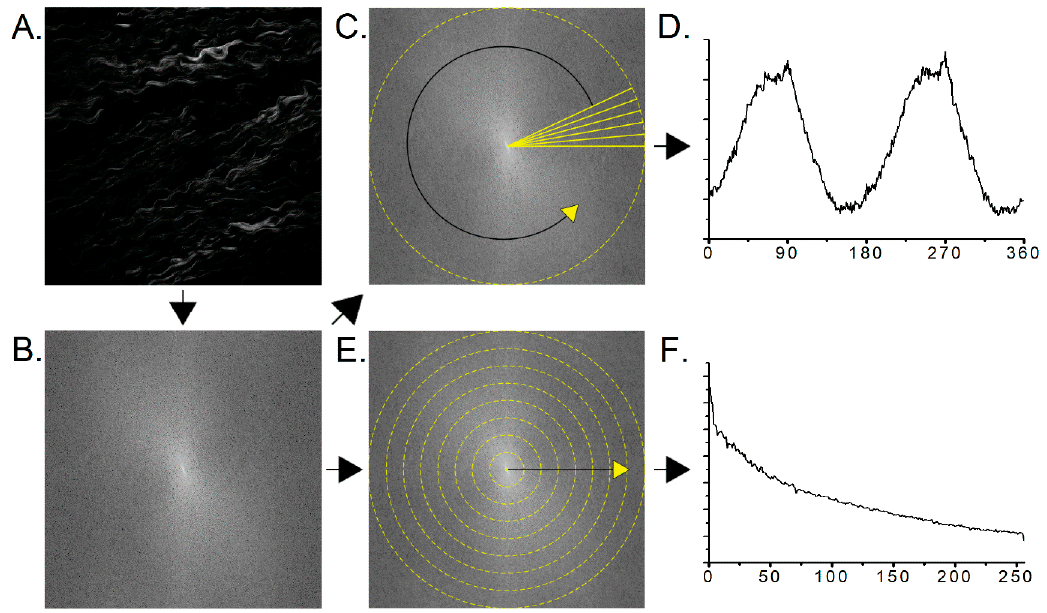
Figure 4. Workflow of the fast fourier transform (FFT) analysis. ( A ) starting image, ( B ) FFT of ( A ) produced in ImageJ. Two different approaches are then utilized to analyze the log-scale FFT. ( C ) Radial sums of the FFT produce the resulting intensity plot ( D ). ( E ) Circular sums of the FFT produce a curve ( F ) which is then fit with a single exponential decay. Field size = 150 × 150 µm.